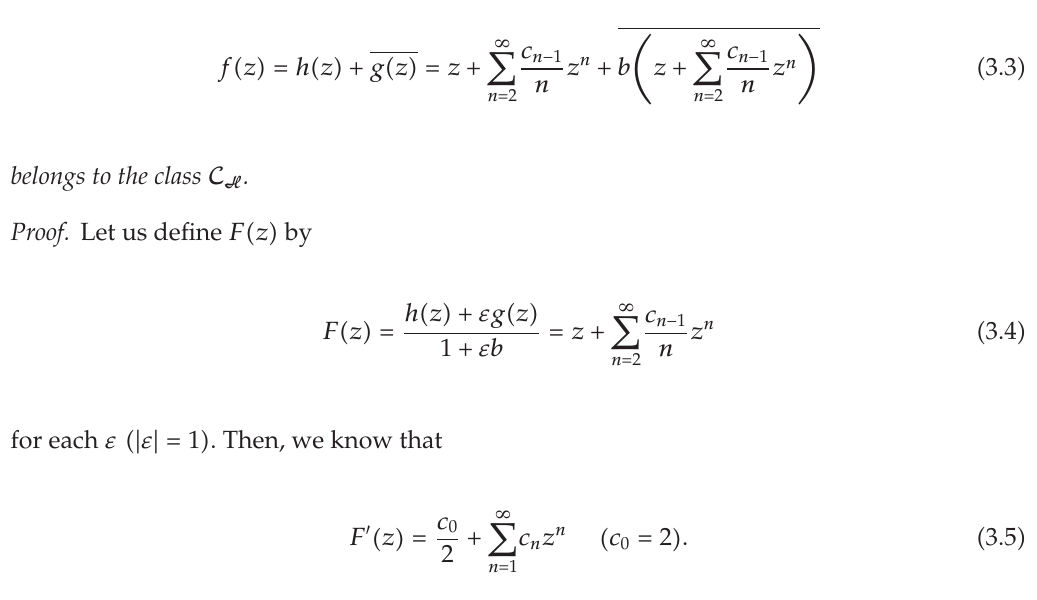
(cid:28) z (cid:3) log (cid:3) 1 − t (cid:4) /t (cid:4) dt (cid:6) (cid:3) z (cid:6) (cid:3) 1 − z (cid:4) log (cid:3) 1 − z (cid:4)(cid:4) 0